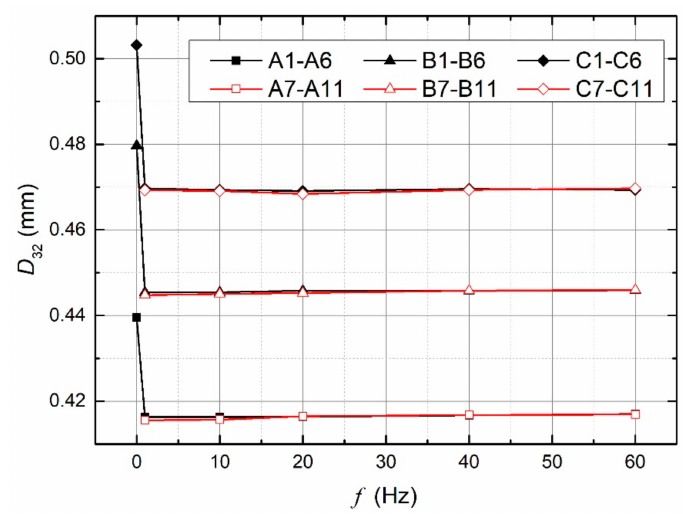
Figure 12. Overall D 32 under computational cases with di ff erent fluctuations.